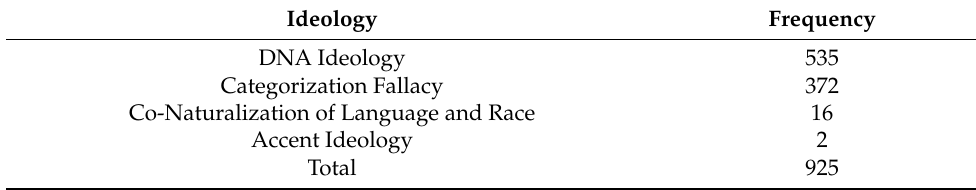
Table 3. Raciolinguistic stance foci